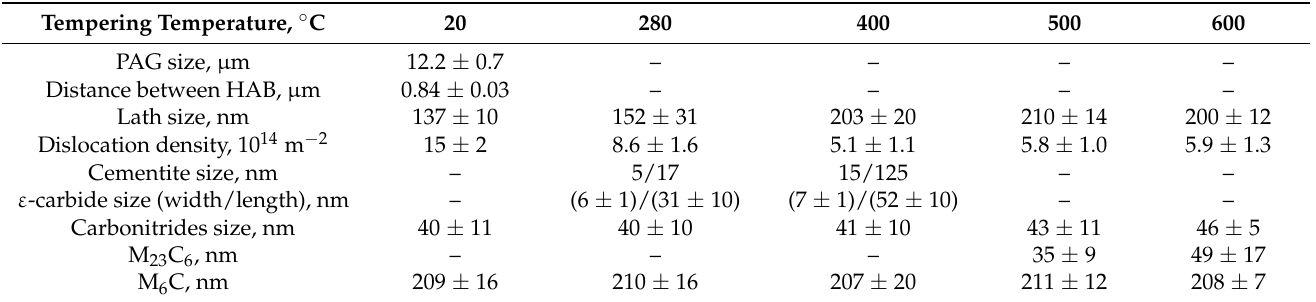
Table 3. Microstructural parameters of the 0.4%C-1.6%Si-1%Cr-0.95%Mo steel with V and Nb after quenching from 900 ◦ C into water and tempering at different temperatures.